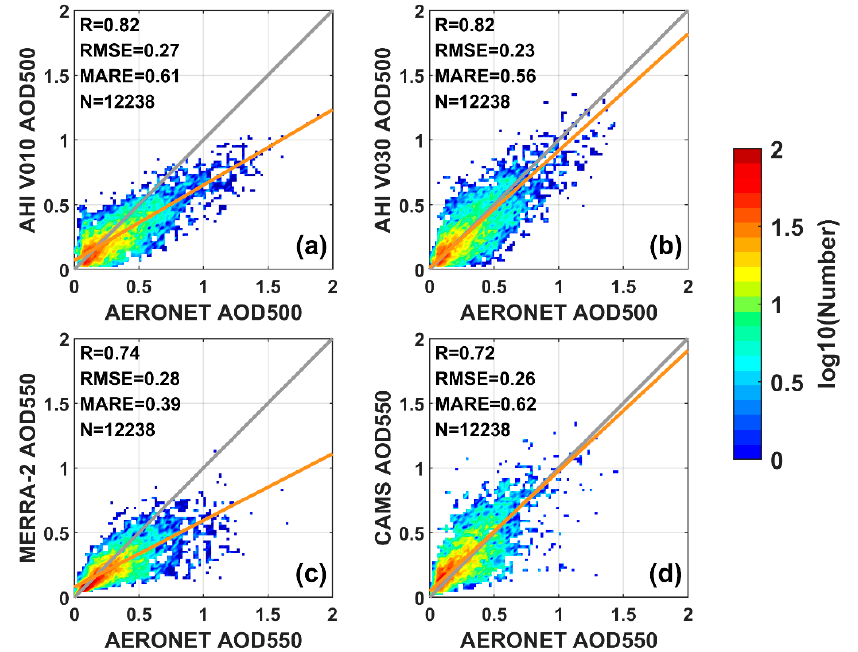
Figure 2. Scatterplots of aerosol optical depths (AOD) from the ( a ) Advanced Himawari Imager (AHI) version 010 (V010), ( b ) AHI V030, ( c ) Modern-Era Retrospective Analysis for Research and Applications, version 2 (MERRA-2), and ( d ) Copernicus Atmosphere Monitoring Service (CAMS) versus AERONET observations. The grey line and orange line refer to the one-to-one line and linear-regression line, respectively. The parameter N is the number of matchups; R, RMSE, and MARE represent the correlation coefficient, the root-mean-square error, and the mean absolute relative error, respectively. Color-bar represents the logarithm of matchup numbers for a corresponding pixel.